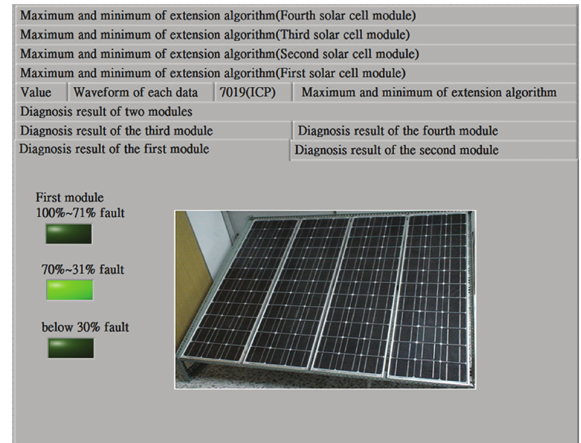
Figure 14: The interface of diagnosis result.